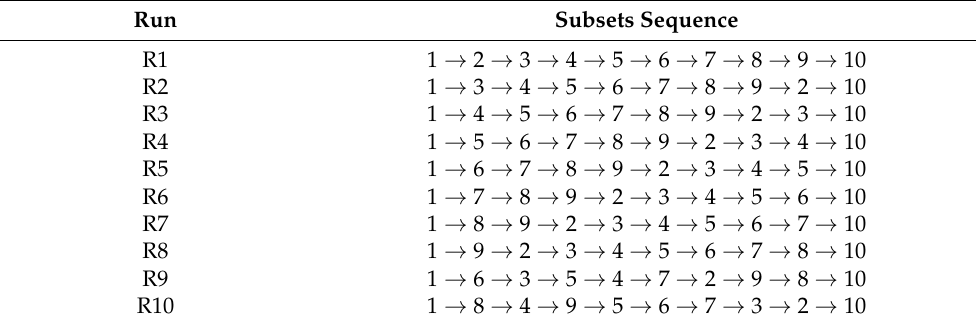
Table 2. Ten runs of the incremental Hoeffding tree learning process—the subsets sequence. Run Subsets Sequence